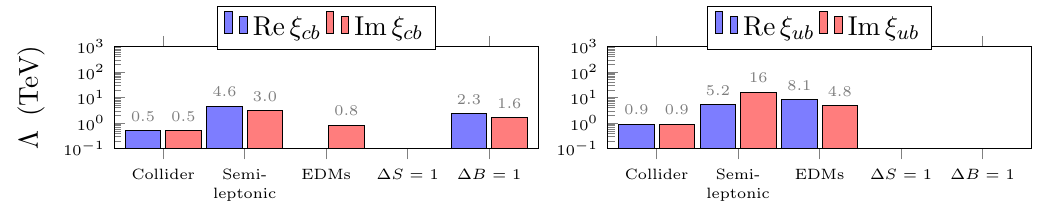
Collider Semi- leptonic Figure 8 . The (cid:12)gure shows naive constraints on (cid:24) cb and (cid:24) ub . Notation is the same as in (cid:12)gure 6. this case, the semileptonic constraint on the imaginary part is weaker due to the fact that the experimental limit on D is signi(cid:12)cantly less stringent than that on D (cid:6) ref. [11], an imaginary part of (cid:24) or (cid:24) can solve the 2 (cid:27) discrepancy between the measured us ud value of (cid:15) 0 =(cid:15) and the SM predictions of refs. [160, 177{180], without con(cid:13)ict with EDM and other low- and high-energy constraints. This manifests in the non-zero values for Im (cid:24) and Im (cid:24) in eq. us